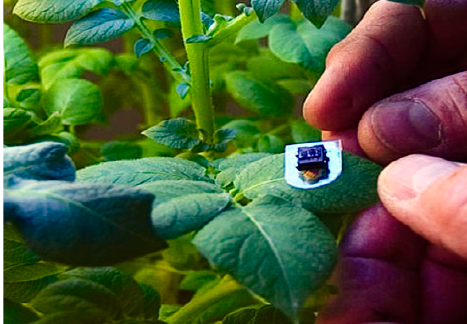
Figure 2. Image of disposable sensor.